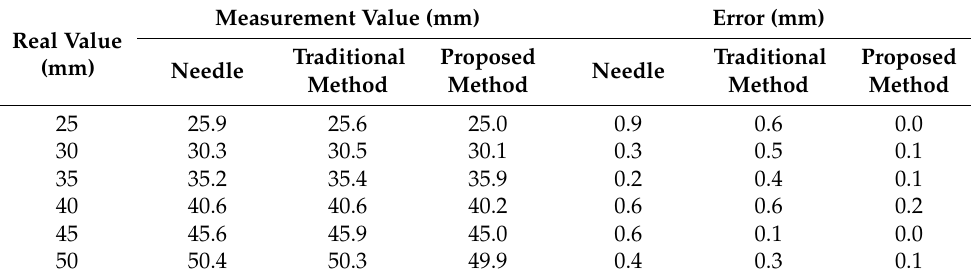
Table 3. Comparison of measurement results.